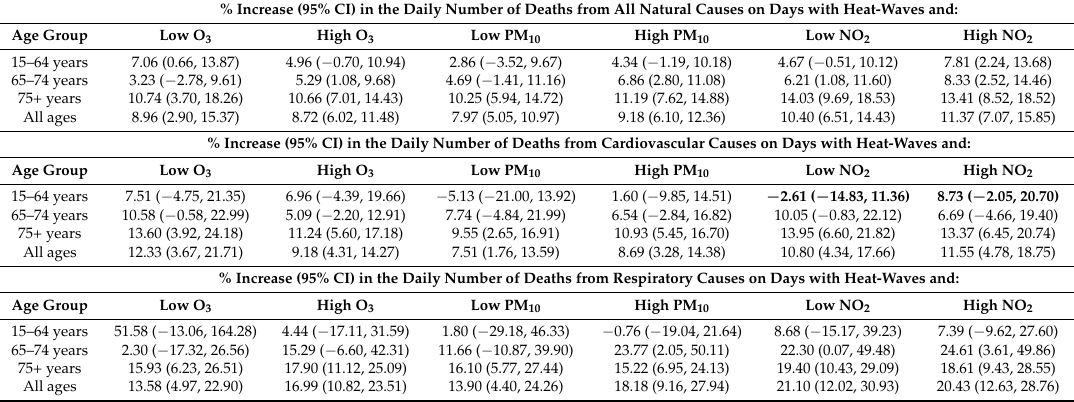
Table 4. Pooled (from nine city-specific estimates) percentage increase (95% CI) in the daily number of deaths in days with a heat wave and with “low” (at the 25th percentile of each city-specific distribution) or “high” (at the corresponding 75th percentile) level of pollutant. Results from random effects